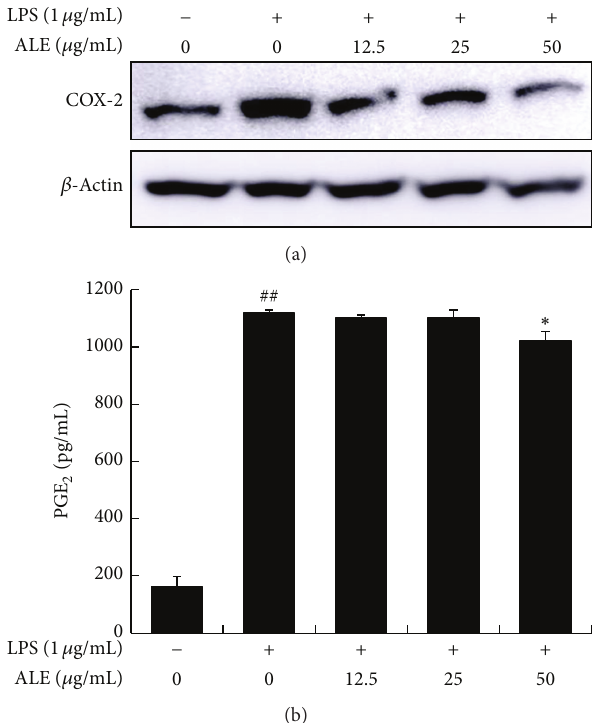
Figure 6: Effects of ALE on COX-2 expression and PGE 2 production in Raw 264.7 cells. Cells were treated with various concentrations of ALE for 4h and then activated with 1 𝜇 g/mL of LPS for 20h. The COX-2 expression levels were then detected by western blot analysis (a), while PGE 2 production was measured by ELISA. Values represented are the means ± SD. ## 𝑃 < 0.01 compared to the NOR group and ∗ 𝑃 < 0.05 compared to the CTL group